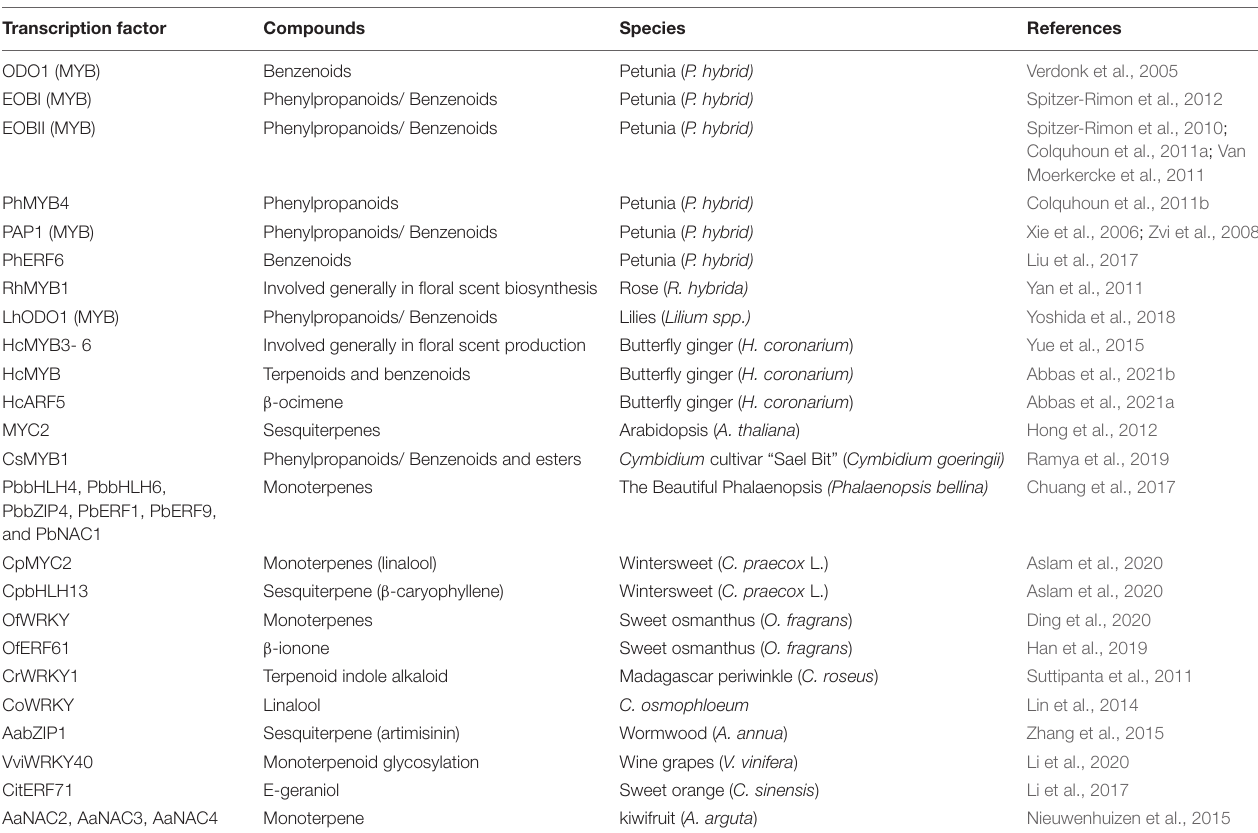
TABLE 2 | Major transcription factors that regulate VOC